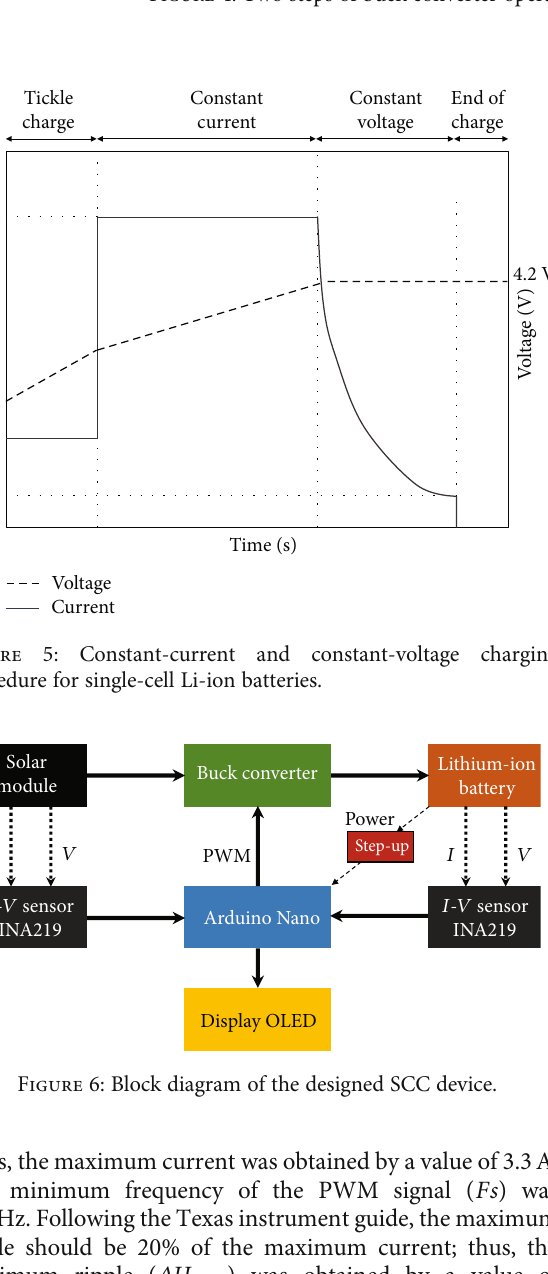
Figure 4: Two steps of buck converter operation: (a) closed circuit step; (b) opened circuit step.